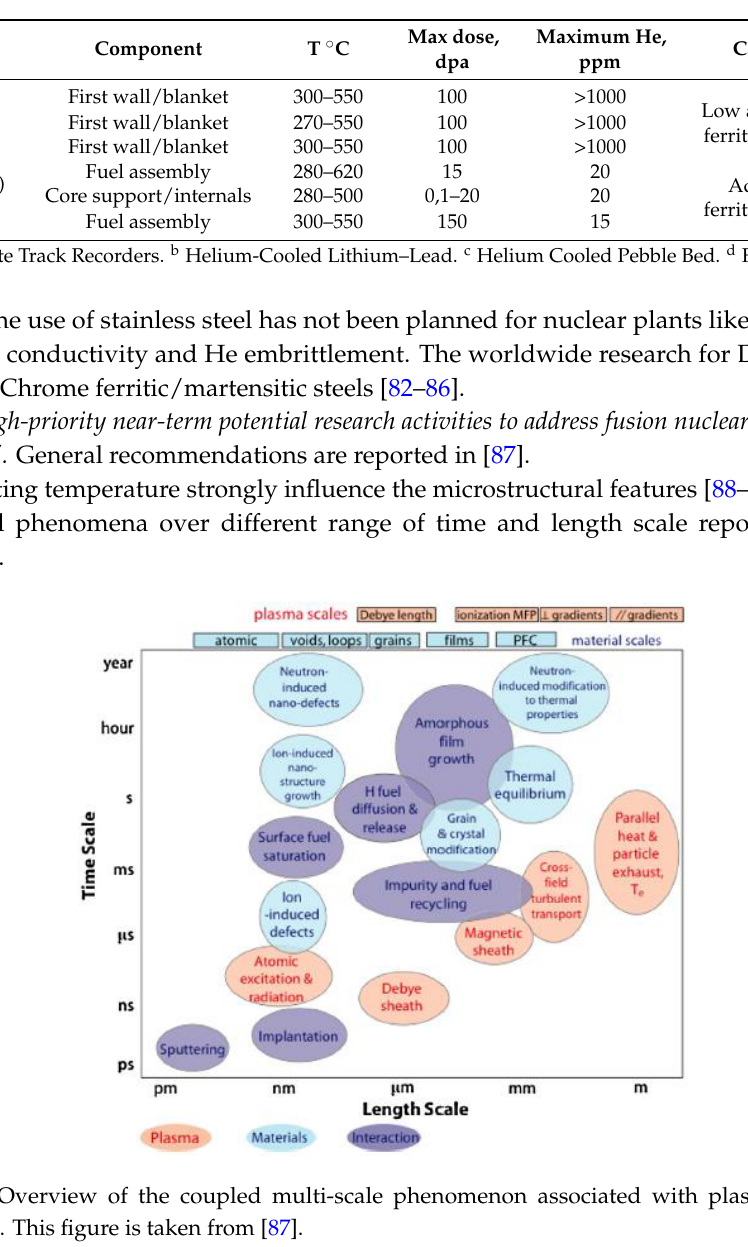
Table 5. Ferritic/martensitic steels: fusion, and Generation IV fission applications. This table is taken from [77].